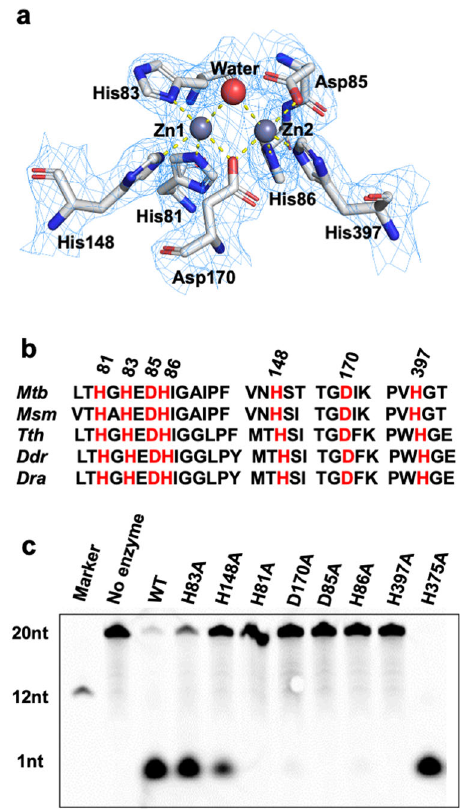
Fig.4|TheactivesitesofMtb-RNaseJ.a TheactivesitesofMtb-RNaseJ.Residues involved in metal chelation were shown as stick models. The Zn 2+ were shown as gray spheres. Yellow dashed lines indicated Zn 2+ coordination. The bridging water was shown as a red sphere. The electron density map was contoured to 2.0 σ . b Sequence alignment of the active sites among different RNase J proteins: Mtb ( Mycobacterium tuberculosis ), Msm ( Mycobacterium smegmatis ), Tth ( Thermus thermophilus ), Bsu ( Bacillus subtilis ), Ddr ( Deinococcus deserti ), and Dra ( Deino- coccus radiodurans ). The conserved binding sites are shown in red. c The ribonu- cleaseactivitiesofMtb-RNaseJandmutantswereassayedwitha20-ntssRNAasthe